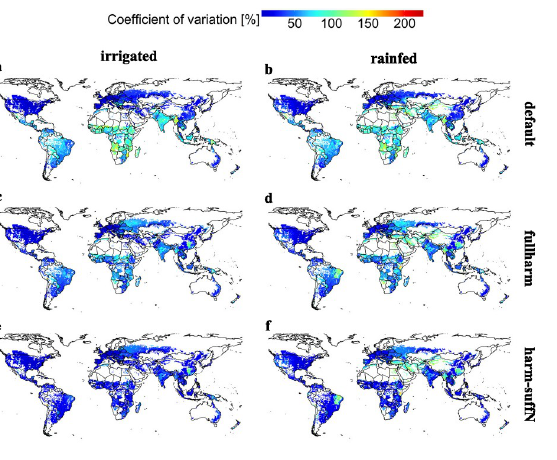
Fig 3. Coefficient of variation for long-term average maize yield estimates (CV av ) among EPIC-based GGCMs. Panels reflect each of the six crop management scenarios defined in Table 1. Complementary maps without EPIC-TAMU, for which default and fullharm are identical, are provided in Fig G in S1